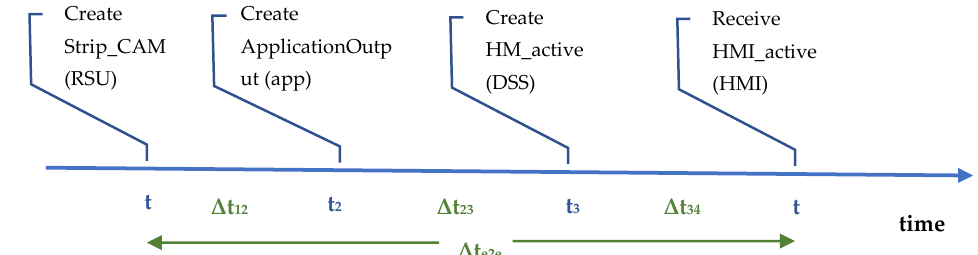
Figure 10. Sequence of messages in the system for the non-equipped vehicle.